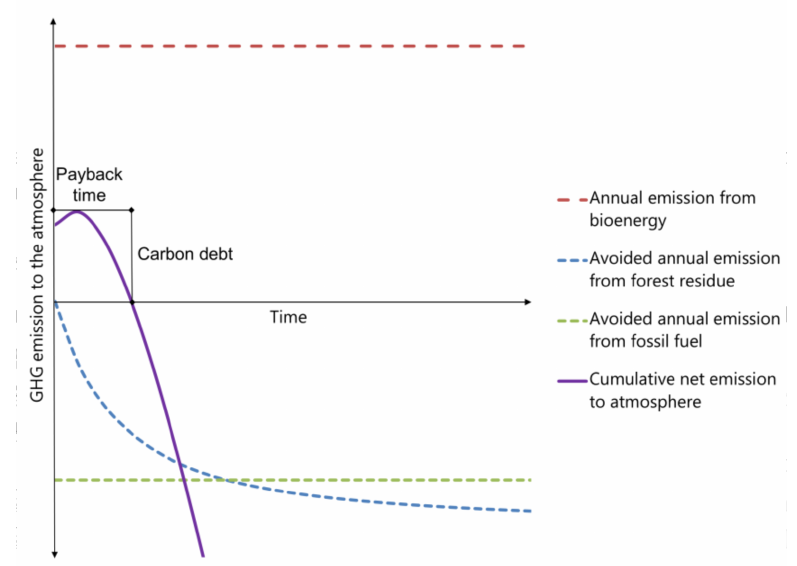
Figure 2. Conceptualized representation of carbon debt and carbon debt payback time with reference to the use of forest residues for energy. Induced greenhouse gas (GHG) emissions from bioenergy are positive, while avoided GHG emissions from the counterfactual fossil supply chain together with avoided GHG emissions from decaying forest residues are illustrated with negative values. Cumulative net emissions correspond to the time integrated difference between induced and avoided GHG